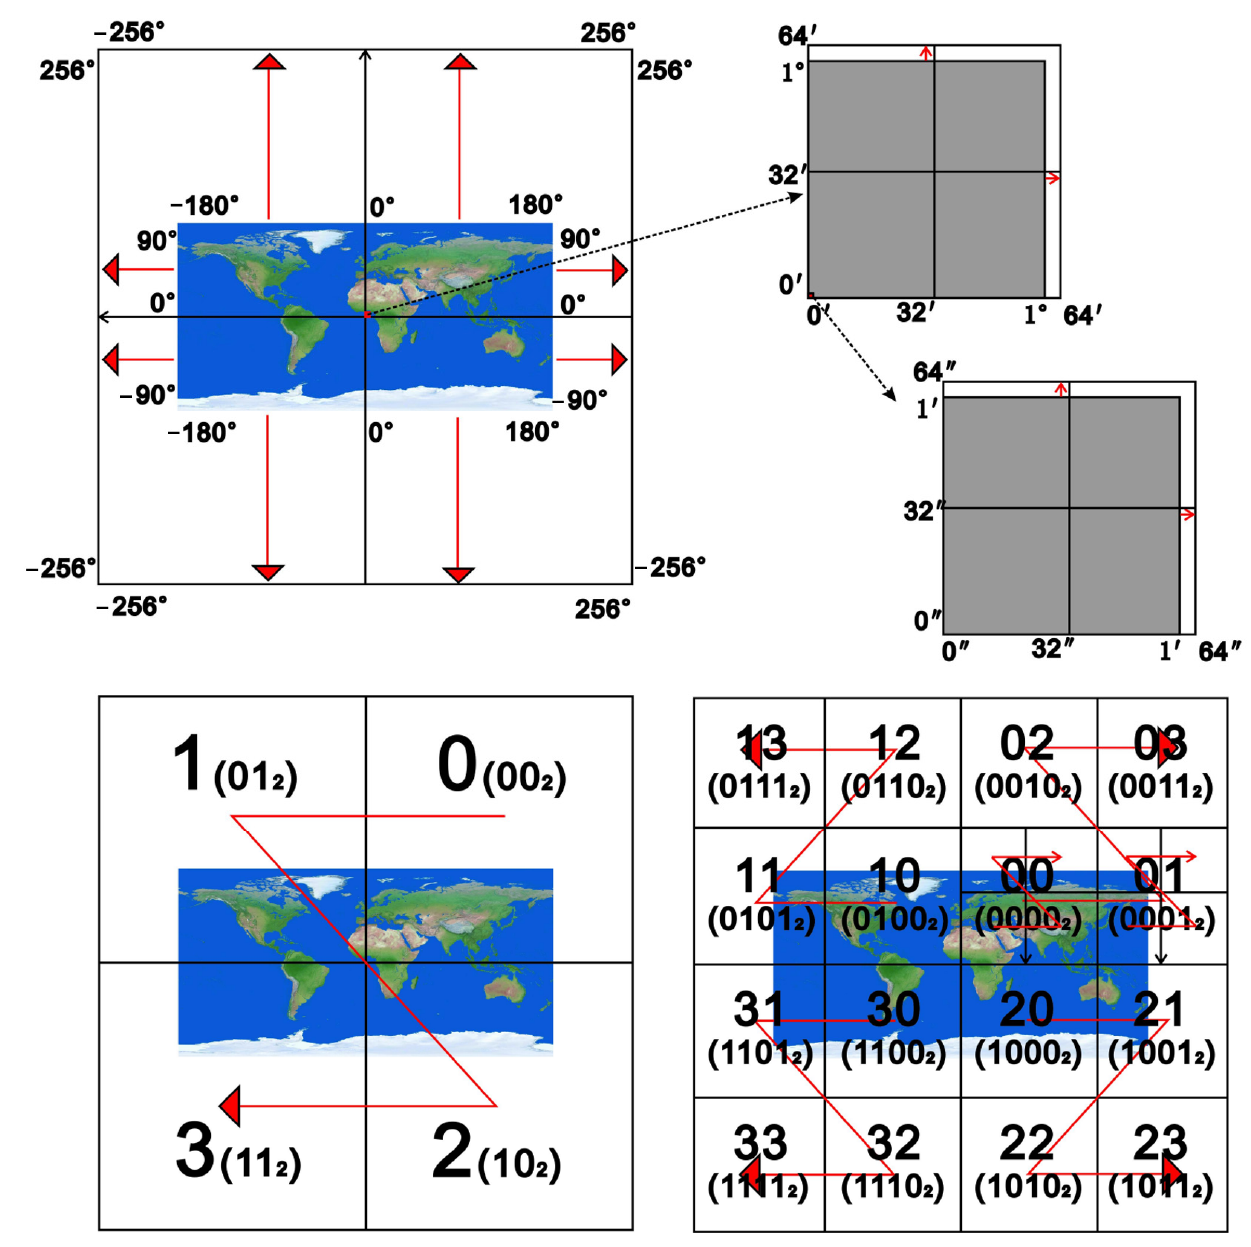
Figure 1. GeoSOT model schematic.